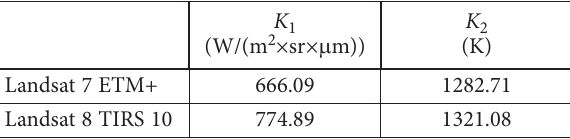
Table 1. The calibration constants for Landsat